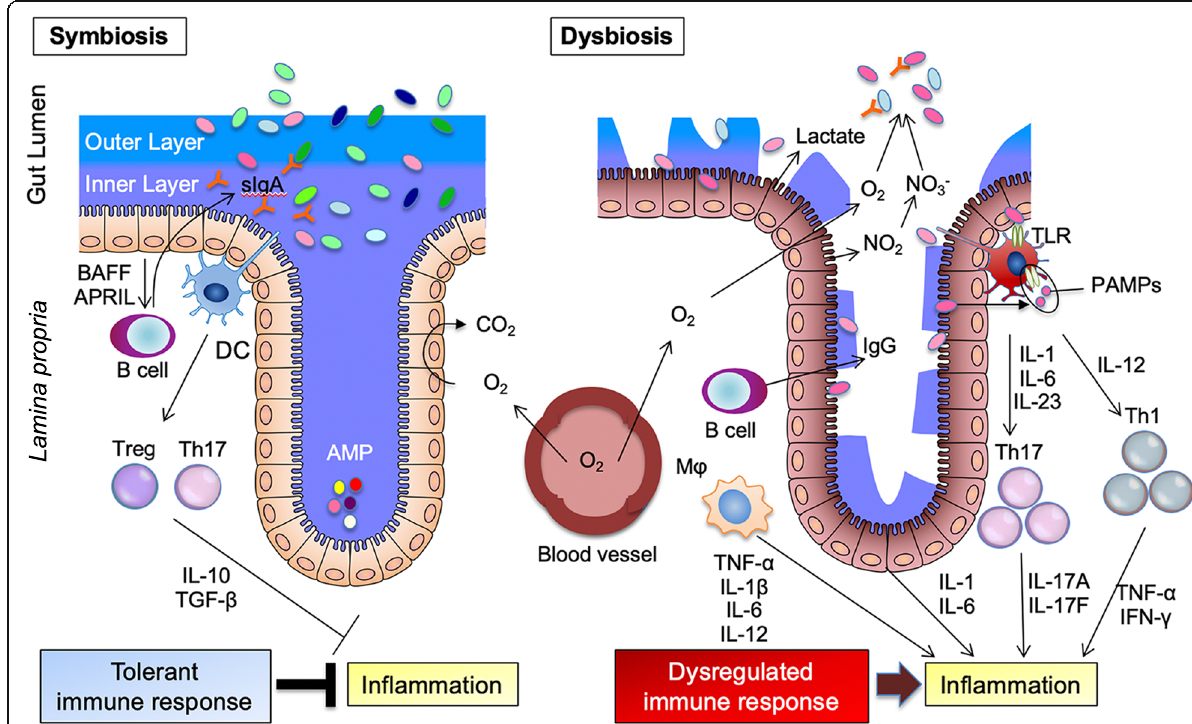
Fig. 1 Gut microbiota regulates immune response. Symbiosis (left): The intestinal immune system within the gut lamina propria becomes largely tolerant to the resident commensals under tight control by intestinal epithelial cells with steady-state proportions of mucus, secretory IgA, and antimicrobial peptides. As a result, the microbiota stays in the intestinal lumen. The gut microbiome stimulates intestinal epithelial cells, T cells, and lamina propria dendritic cells (DCs) and macrophages to promote the development or the activation of forkhead box P3(Foxp3) positive Treg cells. The others activate lamina propria DCs and macrophages to induce T helper 17 (Th17) cells. Toll-like receptor (TLR) activation on intestinal epithelial cells induces the secretion of B cell-activating factor (BAFF) and A proliferation-inducing ligand (APRIL), which promote the differentiation of IgA- producing plasma cells. CD103-positive DCs support the development of Tregs to secrete IL10 and TGF- β , and they also stimulate B cells to produce commensal-specific IgA. Dysbiosis (right): Dysbiosis is a condition characterized by a loss of symbiotic bacteria and overgrowth of pathobionts. Pathobiont overgrowth leads to the loss of barrier integrity and a breach in the intestinal epithelial cell barrier. Translocation of pathobionts, bacterial components, and diverse pathogen-associated molecular patterns (PAMPs) triggers the intestinal immune system through TLR activation, resulting in chronic inflammation involving hyperactivation of T helper 1 (Th1) and Th17 cells. The secretion of inflammatory cytokines from intestinal epithelial cells exacerbates a Th1 and Th17 response by DCs and macrophages and leads to the accumulation of commensal-specific IgG by B cells. Additionally, disruption of the gut microbiota changes the metabolism of colonocytes, which is characterized by low oxygen consumption and generation of nitric oxide (NO) followed by synthesis of inducible nitric oxide synthase (iNOS). NO converts into nitrate (NO 3 − ) in the intestinal lumen and drives the expansion of facultative anaerobic bacteria, including pathobionts with excessive oxygen (O 2